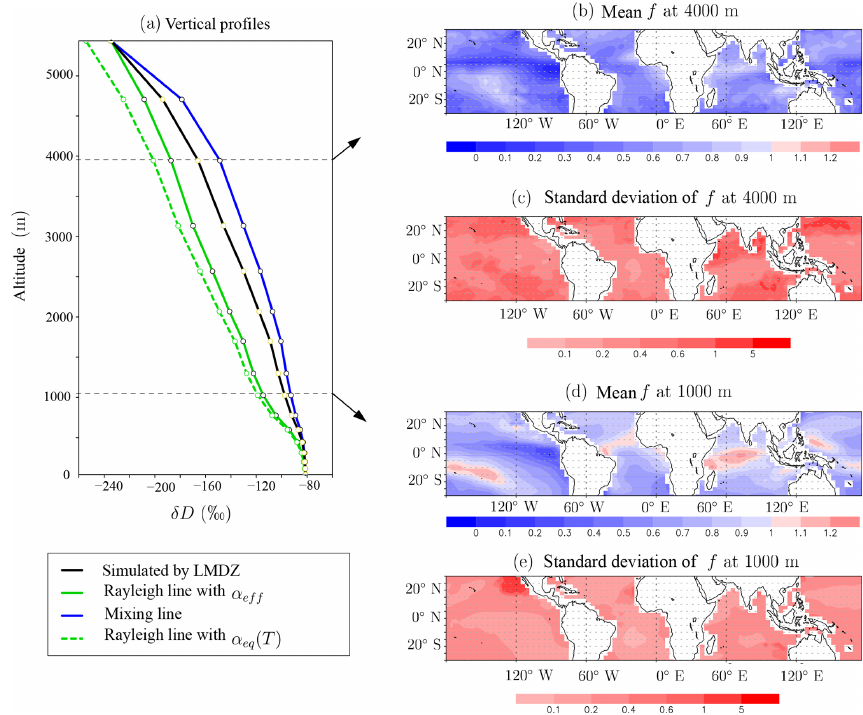
Figure D1. (a) Vertical profiles of water vapor δD simulated by LMDZ (black), calculated if assuming a Rayleigh-type curve with α eff estimated from (q f ,δD f ) at 500hPa (green), calculated if assuming a Rayleigh-type curve with α eq (T ) (dashed green), and calculated if assuming a mixing curve between the first layer and (q f ,δD f ) at 500hPa (blue), on average over all tropical oceanic locations and days. δD LMDZ − δD Rayleigh (b) Winter-mean map of parameter f = at 4000m, i.e., slightly below 500hPa where q f and δD f are taken. Parameter f δD mix − δD Rayleigh describes how close the simulated δD ( δD LMDZ ) is to the Rayleigh ( δD Rayleigh ) and mixing lines ( δD mix ): f = 0 in case of a Raleigh line, f = 1 in case of a mixing line, and f > 1 if δD is more enriched than a mixing line. (c) Standard deviation of parameter f among all days in winter of all years, at 4000m. (d) Same as (b) but at 1000m, i.e., slightly above the LCL. (e) Same as (c) but at 1000m. To avoid numerical problems, only days and locations where | δD mix − δD Rayleigh | > 5‰ are used in the calculations.